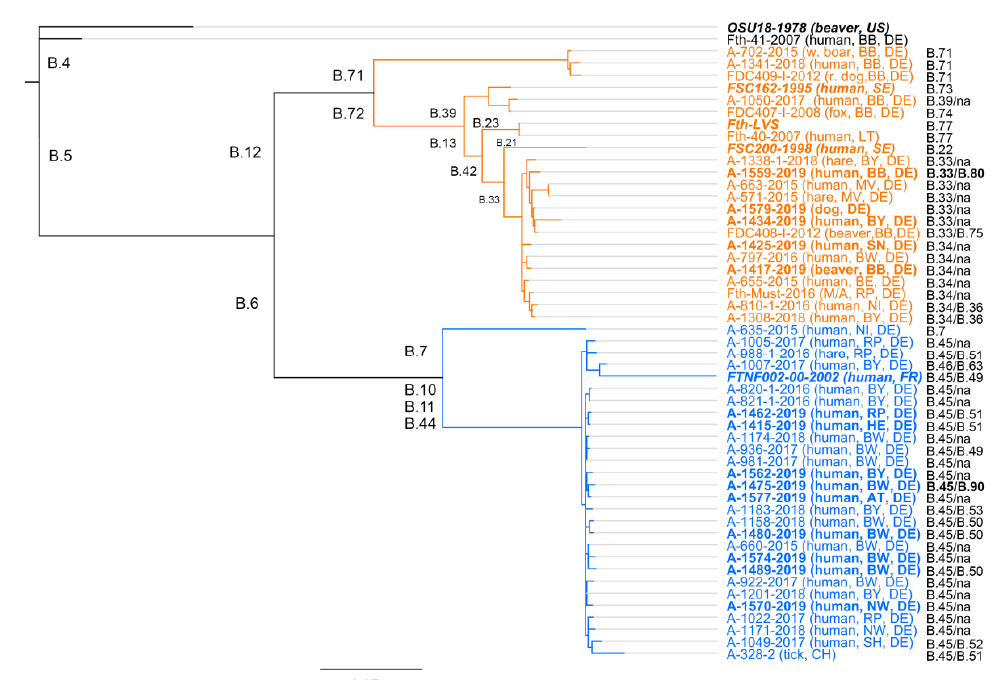
Figure 1. Phylogenetic relationship of Francisella tularensis subsp. holarctica isolates from 2007–2019 in Germany. The analysis was based on a Mauve alignment for collinear genomes. Genomes were generated by DNA sequencing and mapping of obtained DNA reads to the genome of F. tularensis subsp. holarctica (Fth) live vaccine strain (LVS) (for details, see [17]). For the clustering, the neighbor joining bootstrap method was chosen, with F. tularensis subsp. holarctica strain OSU18 as an out-group. Outlined for each genome are the identifier of the isolate and the year of sampling, the host organism, and the sampling spot (Germany’s federal state). In addition, the respective Francisella clade and final subclade (na = not determined) for each genome is given. The sequences obtained from isolates in 2019 (not published elsewhere yet) and some reference genomes included in the analysis are given in bold. Abbreviations: Austria (AT), France (FR), Lithuania (LT), United States (US), Sweden (SE) and Switzerland (CH). Germanys federal states: BB: Brandenburg; BE: Berlin; BW: Baden-Württemberg, BY: Bavaria; HE: Hesse, MV: Mecklenburg-Western Pomerania; NI: Lower